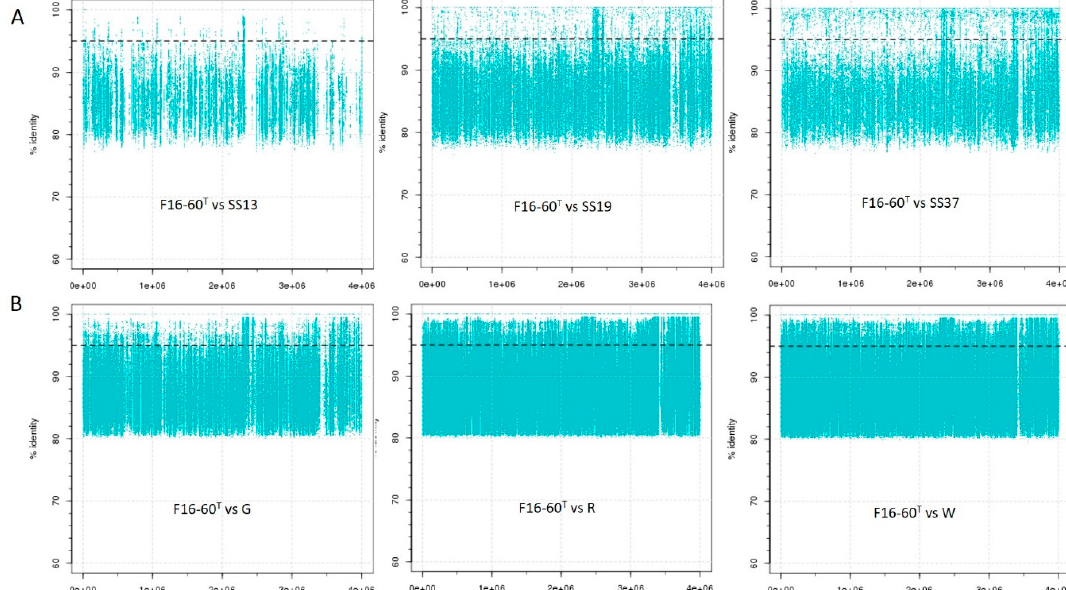
Figure 5. Metagenomic fragment recruitment plots of strain F16-60 T against the metagenomic datasets: ( A ) SS13, SS19, and SS37, from Santa Pola saltern; ( B ) G, R, and W from Lake Meyghan (Iran). In each panel the Y-axis represents the identity percentage and X-axis represents the genome length. A restrictive cut-off 95% of nucleotide identity in at least 30 bp of the metagenomic read was used. The black dashed line shows the threshold for the presence of the same species (95% identity). Abbreviations: SS13: Metagenome from Santa Pola saltern (Spain) with 13% salinity; SS19: Metagenome from Santa Pola saltern (Spain) with 19% salinity; SS37: Metagenome from Santa Pola saltern (Spain) with 37%